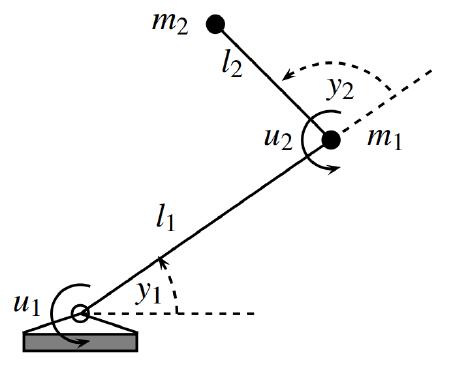
Figure 1. Planar rigid revolute joint robotic manipulator.